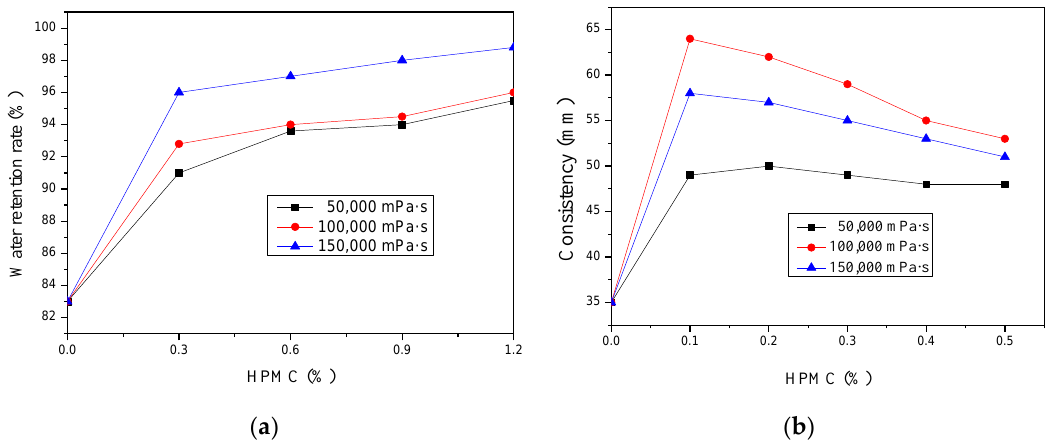
Figure 9. Influence of hydroxypropyl methylcellulose (HPMC) on the performance of fresh mortar: ( a ) Water retention rate, ( b ) consistency.